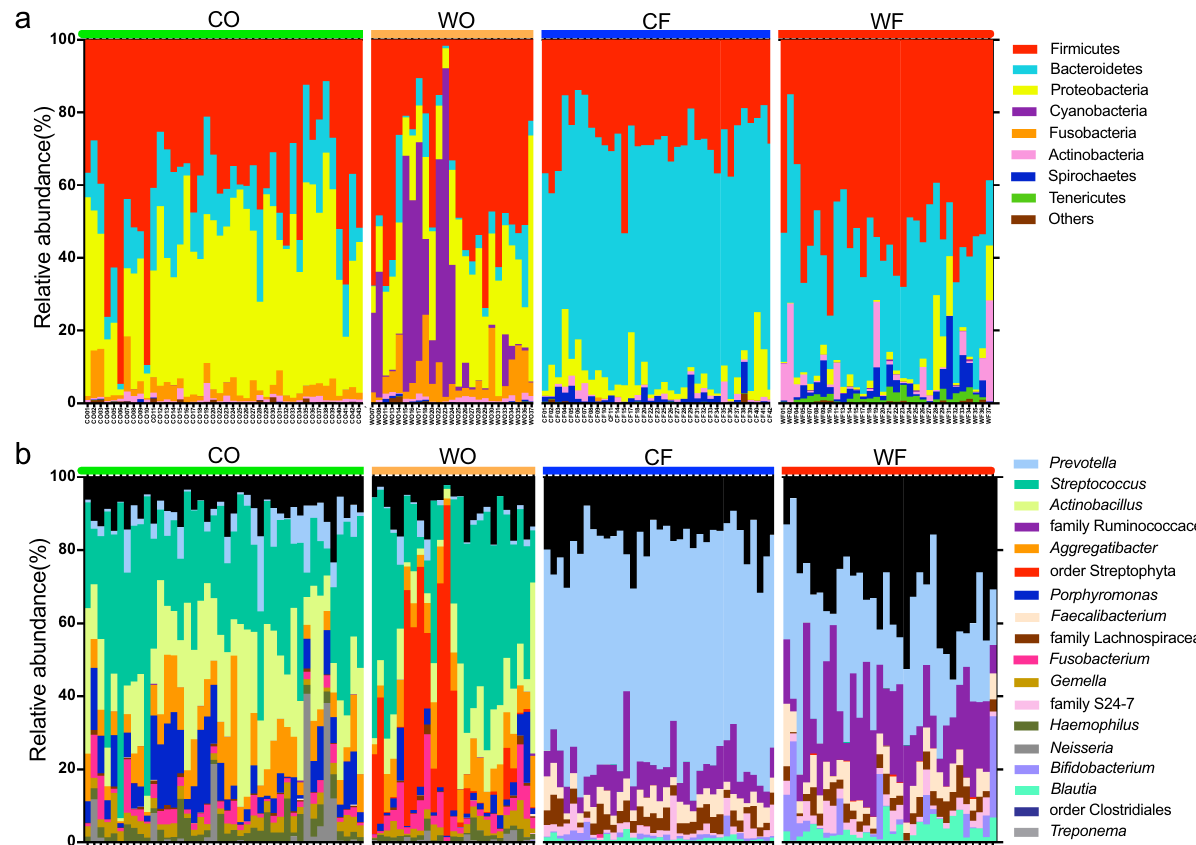
Figure 2. Relative abundance of bacteria in wild and captive long-tailed macaques from 16S microbiome sequencing. The bar plots showed the relative abundance of ( a ) bacterial phylum and ( b ) bacterial genera of classified taxa which were classified by Qiime2 pipeline ( CO captive-oral, WO wild-oral, CF captive-fecal, WF